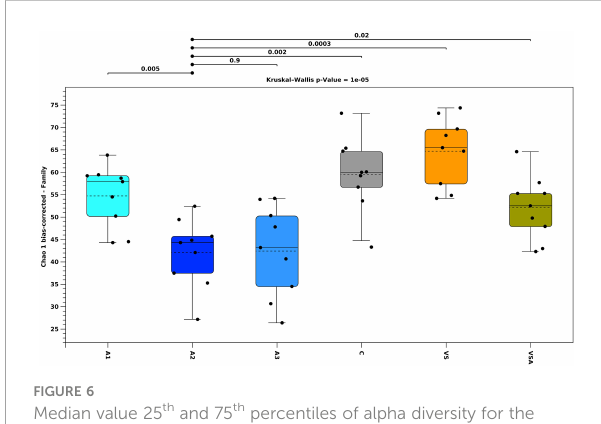
FIGURE 5 Median value 25 th and 75 th percentiles of alpha diversity for the microbial bio fi lms (total number of families) for the total seedlings in black and the three adult whole thalli in gray. Circles indicate treatments and time in seedlings whereas positions (i.e., basal holdfast, fertile and not fertile apices) in adult